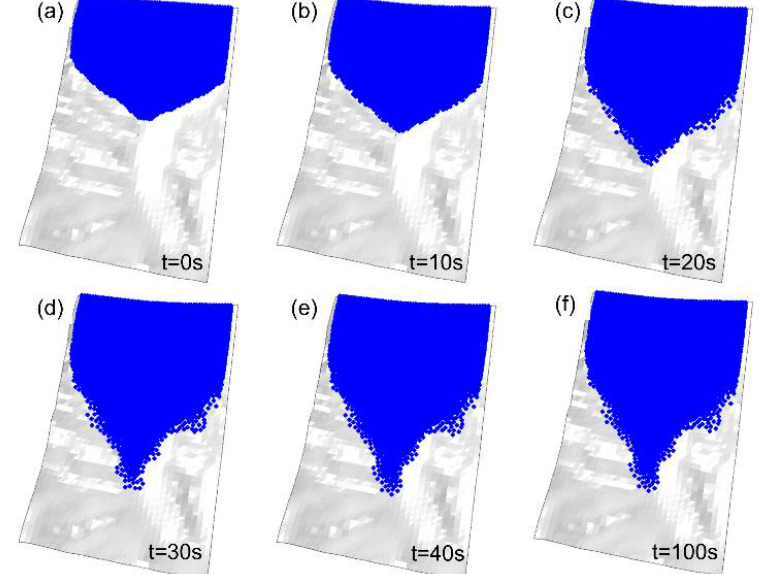
Figure 10. The motion of the landslides by SPH simulation for the full high waste dump at ( a ) t = 0 s; ( b ) t = 10 s; ( c ) t = 20 s; ( d ) t = 30 s; ( e ) t = 40 s; and ( f ) t = 100 s. The total displacement contours (U-Magnitude) of the full high waste dump at t = 10 s, 20 s, 35 s, and 100 s are indicated in Figure 11. When t = 10 s, the displacement near the dump’s centerline is the largest but gradually decreases to both sides. When t = 20 s, the soils on both sides of the dump are blocked by the hillsides on both sides of the dump, which begin to accumulate. This is why some of them converge into the valley below the dump. When t = 35 s, the maximum displacement of the landslides reaches 594.6 m, which is close to the corresponding movement distance 601.9 m of the sliding bodies at the simulation time t = 100 s. This shows that the landslides tend to cease within 30– 40 s. Figure 11. Total displacement (U-Magnitude) contour of the landslides for the full high waste dump at ( a ) t = 10 s; ( b ) t = 20 s; ( c ) t = 35 s and ( d ) t = 100 s. Next, the velocity contours (V-Magnitude) from t = 1 s to t = 100 s are given in Figure 12. It is shown that the landslides first experience an acceleration process, then decelerate and tend to cease